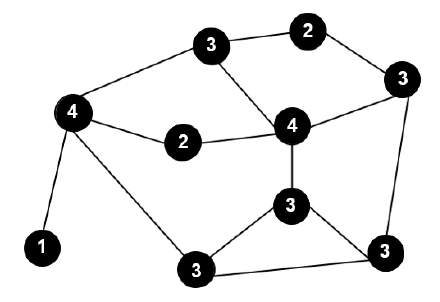
Figure 7. Interconnected density (ICD) of each vertex in a graph.